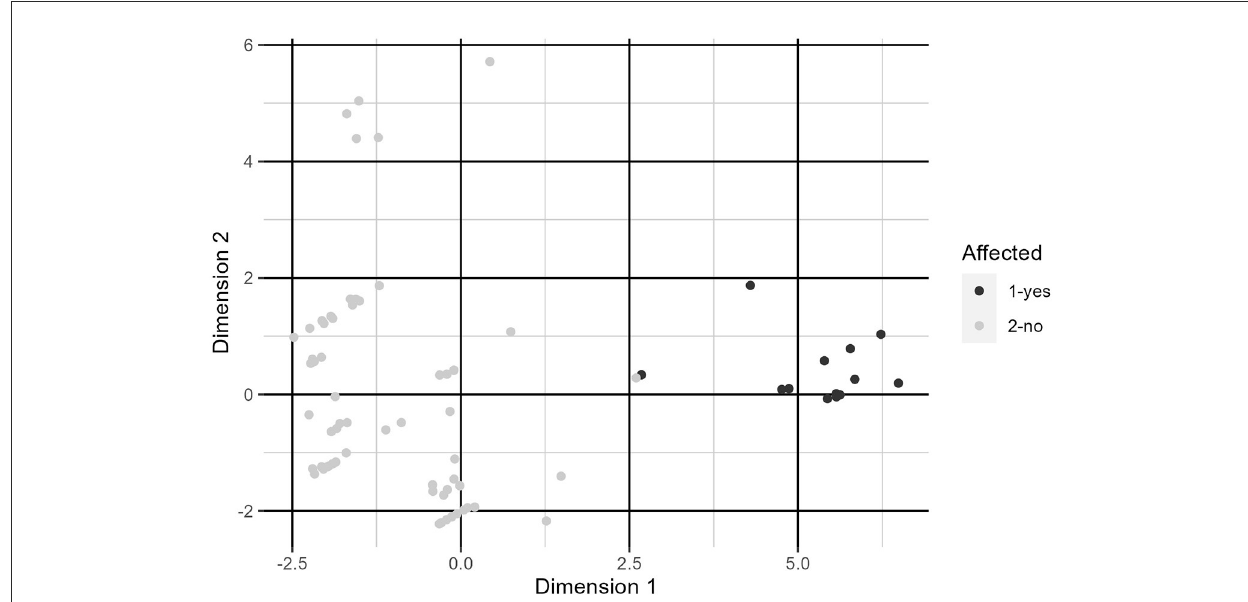
FIGURE3 Plot of individuals along dimensions constructed by FAMD. See Table 6 for variable loadings.